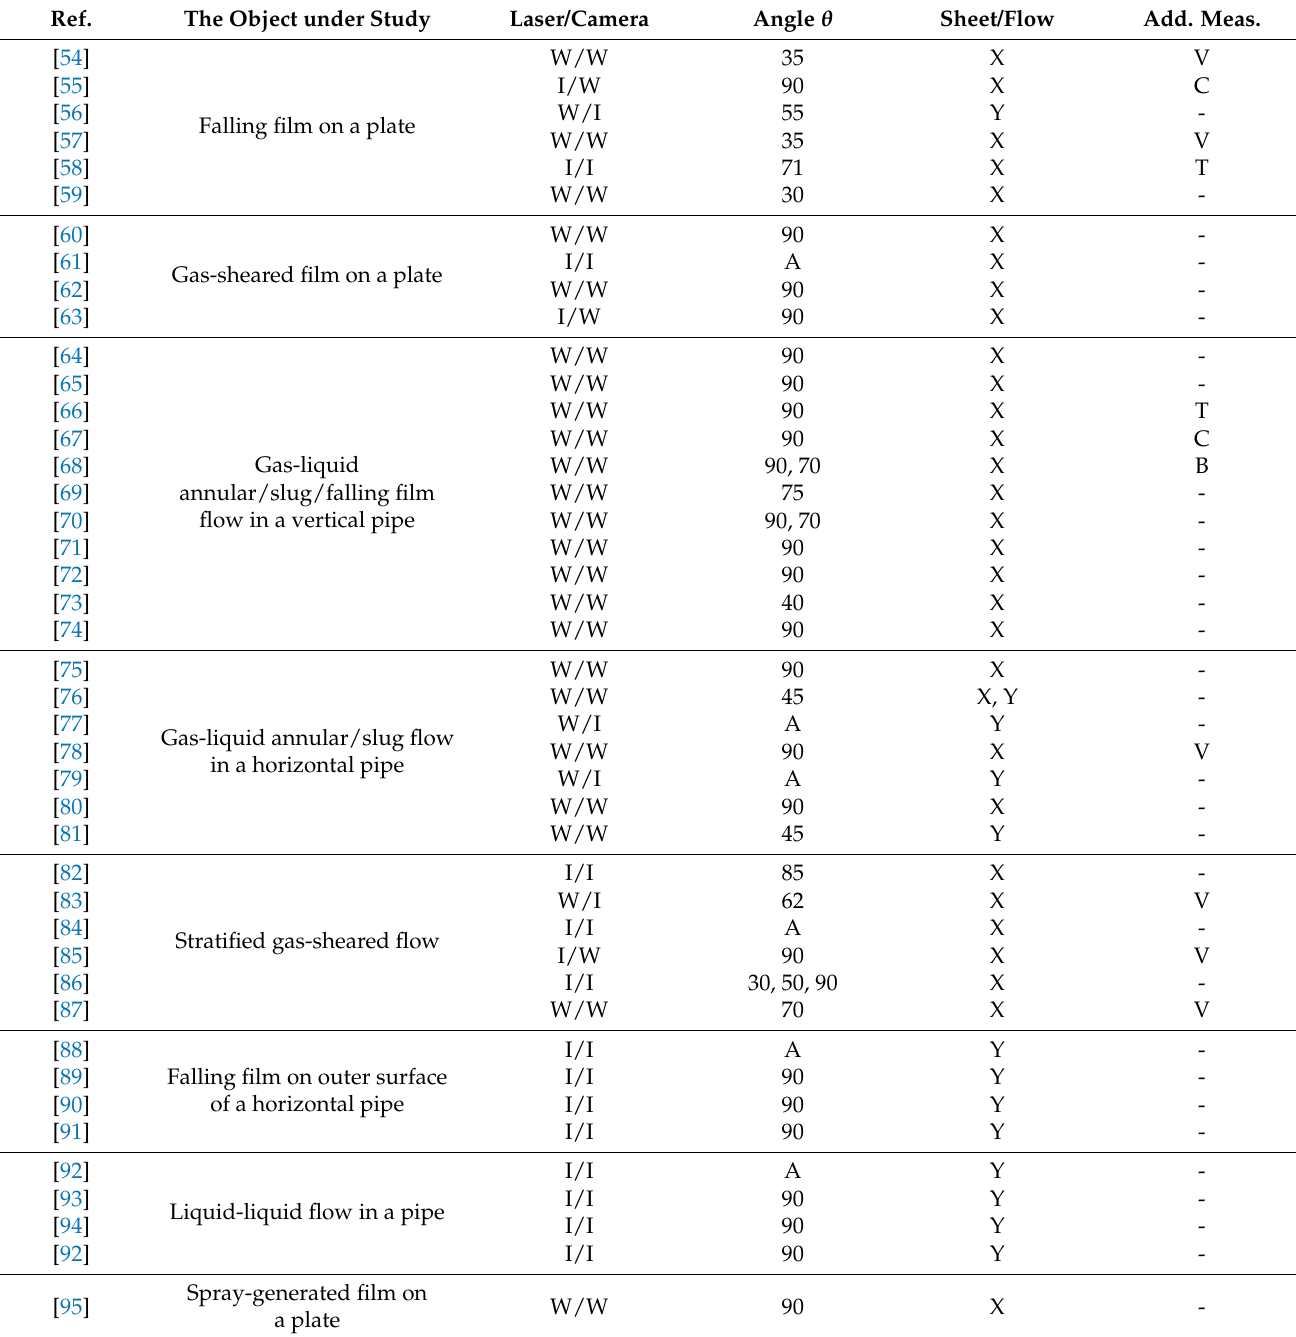
Table 1. A summary of experimental works employing PLIF for film thickness measurements. “X”/“Y”—measurement plane is along/across the flow direction; “W”/”I”—camera and laser are directed from the wall/interphase side; “A”—acute angle in unspecified; “C”,”V”, and “T” indicate velocity, concentration, and temperature measurements,